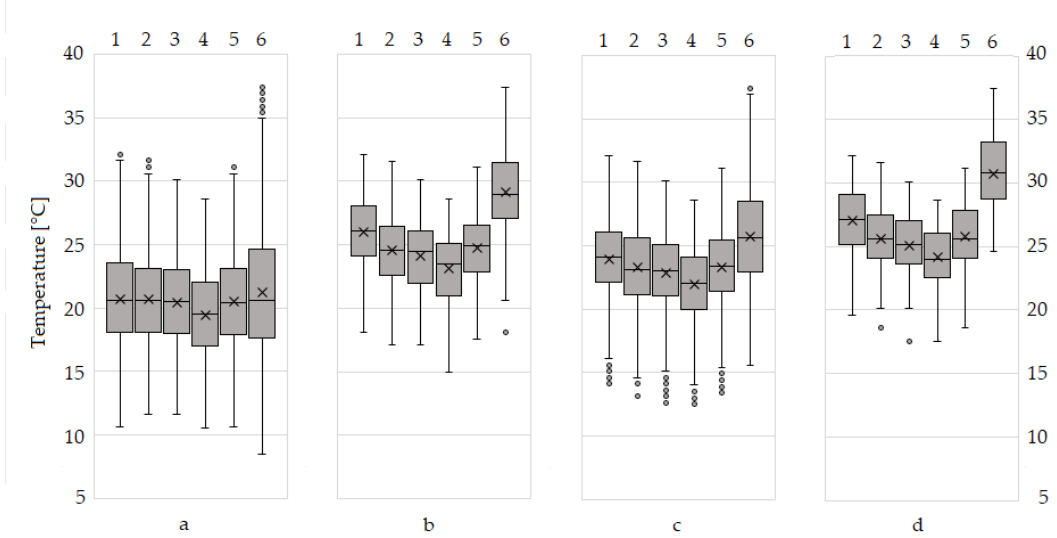
Figure A1. Boxplots with mean (x), median (horizontal line), 25 and 75 percentiles, and minima and maxima of air temperature in the study period at the six measuring points, given for all measured values ( a ), the recorded daytime maxima ( b ), the daytime means recorded in cloudless periods ( c ), and the daily maxima recorded in cloudless periods ( d ). The six measuring points are 1 = Oa, 2 = Oa/Be(lo), 3 = Oa/Be(up), 4 = Be, 5 = Be(N), and 6 = Ga.